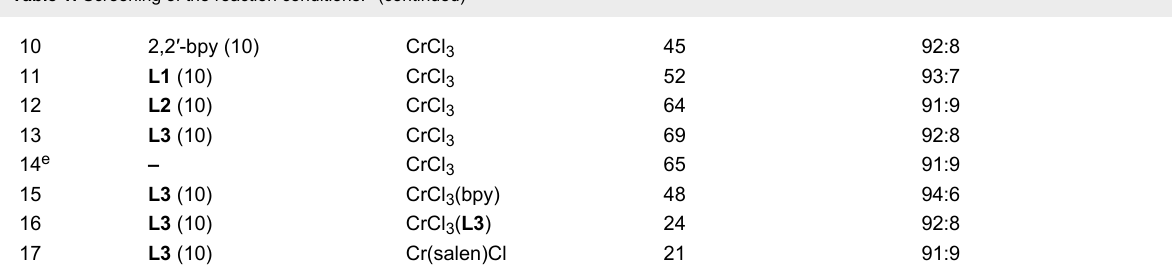
Table 1: Screening of the reaction conditions. a (continued)